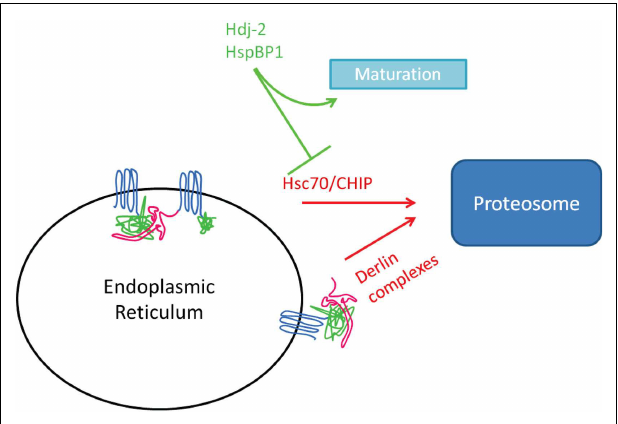
FIGURE 1 | Complexes implicated in